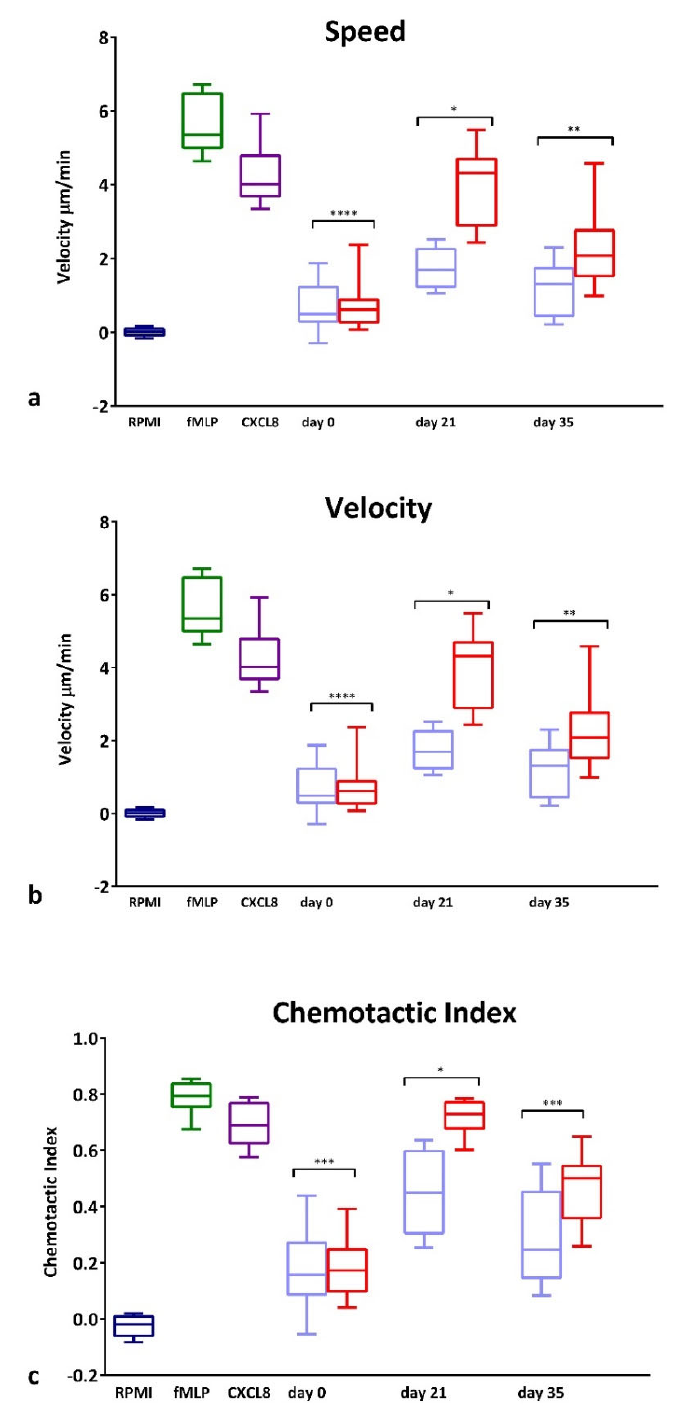
Figure 3. PBN Chemotaxis towards GCF from experimental gingivitis volunteers. Chemotaxis of PBNs isolated from periodontally and systemically healthy blood donors. Chemotaxis analysis was used to generate average ( a ) speed, ( b ) velocity and ( c ) chemotactic index (CI) for neutrophils in the presence of RPMI (negative control, dark blue), fMLP (10 nM, dark green) and CXCL8 (200 ng/mL, dark purple) chemoattractants or towards GCF diluted to 25 ug/mL. Data presented in light blue (at day 0, 21 and 35) show GCF collected from control side and data presented in red show GCF collected from test side used as chemoattractant. Statistical test: Wilcoxon test to compare test and control GCF locations. * p < 0.05, ** p < 0.01, *** p <0.001, **** p < 0.0001.